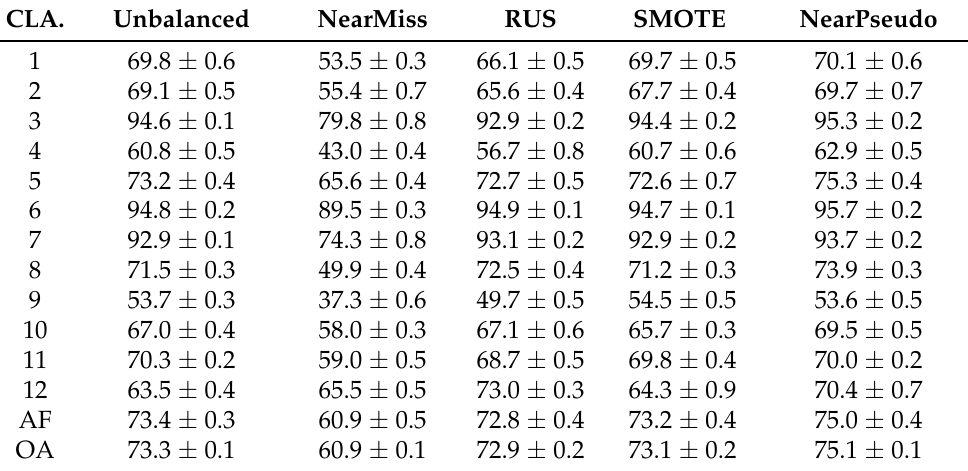
Table 3. Classification accuracy (%) of different solutions on sub-training data T2 .